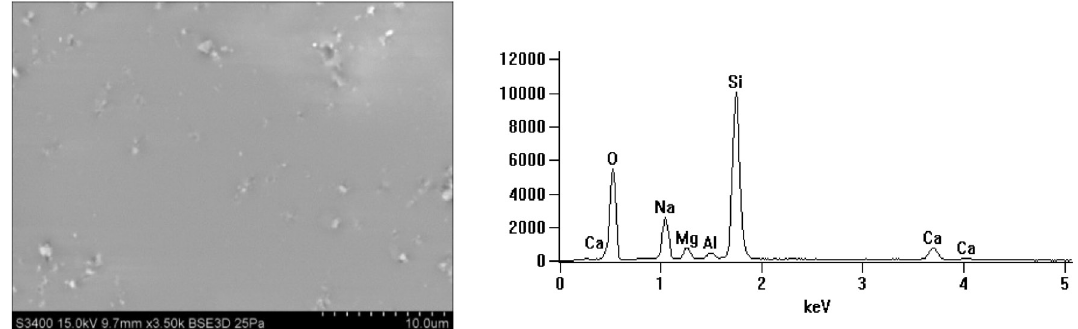
Fig. 3: Results of microstructure and EDS/SEM analysis of glass refined using alumina (TG) nano-particles